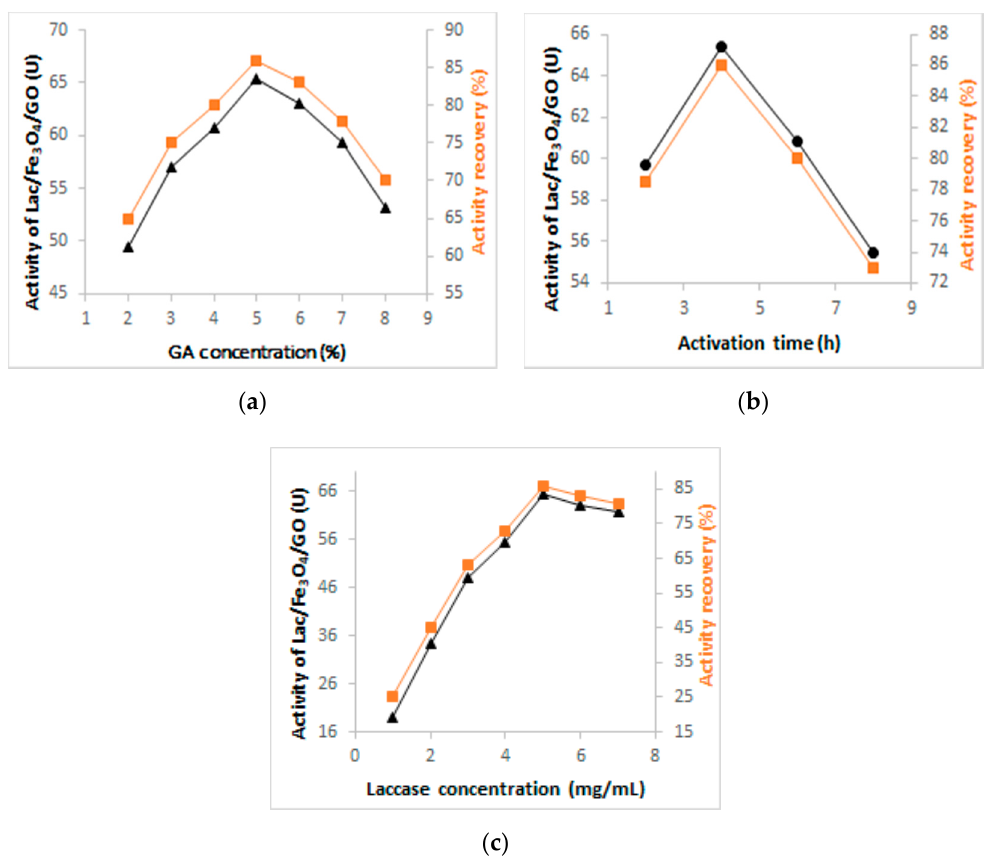
Figure 1. Investigation of the optimum conditions for the preparation of Lac/Fe 3 O 4 /GO: ( a ) Effect of GA concentration, ( b ) activation time and ( c ) concentration of laccase in the synthesis of Lac/Fe 3 O 4 /GO.